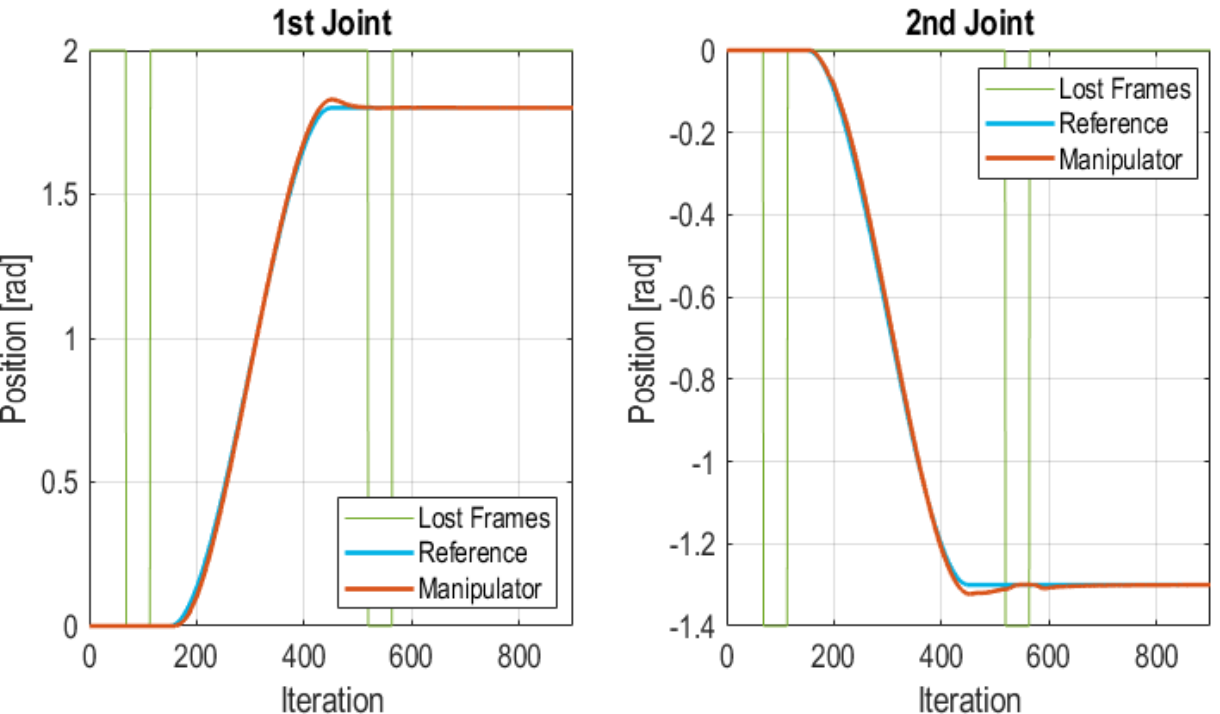
Figure 13. FLC for a cubic trajectory with burst of lost frames while in steady state.